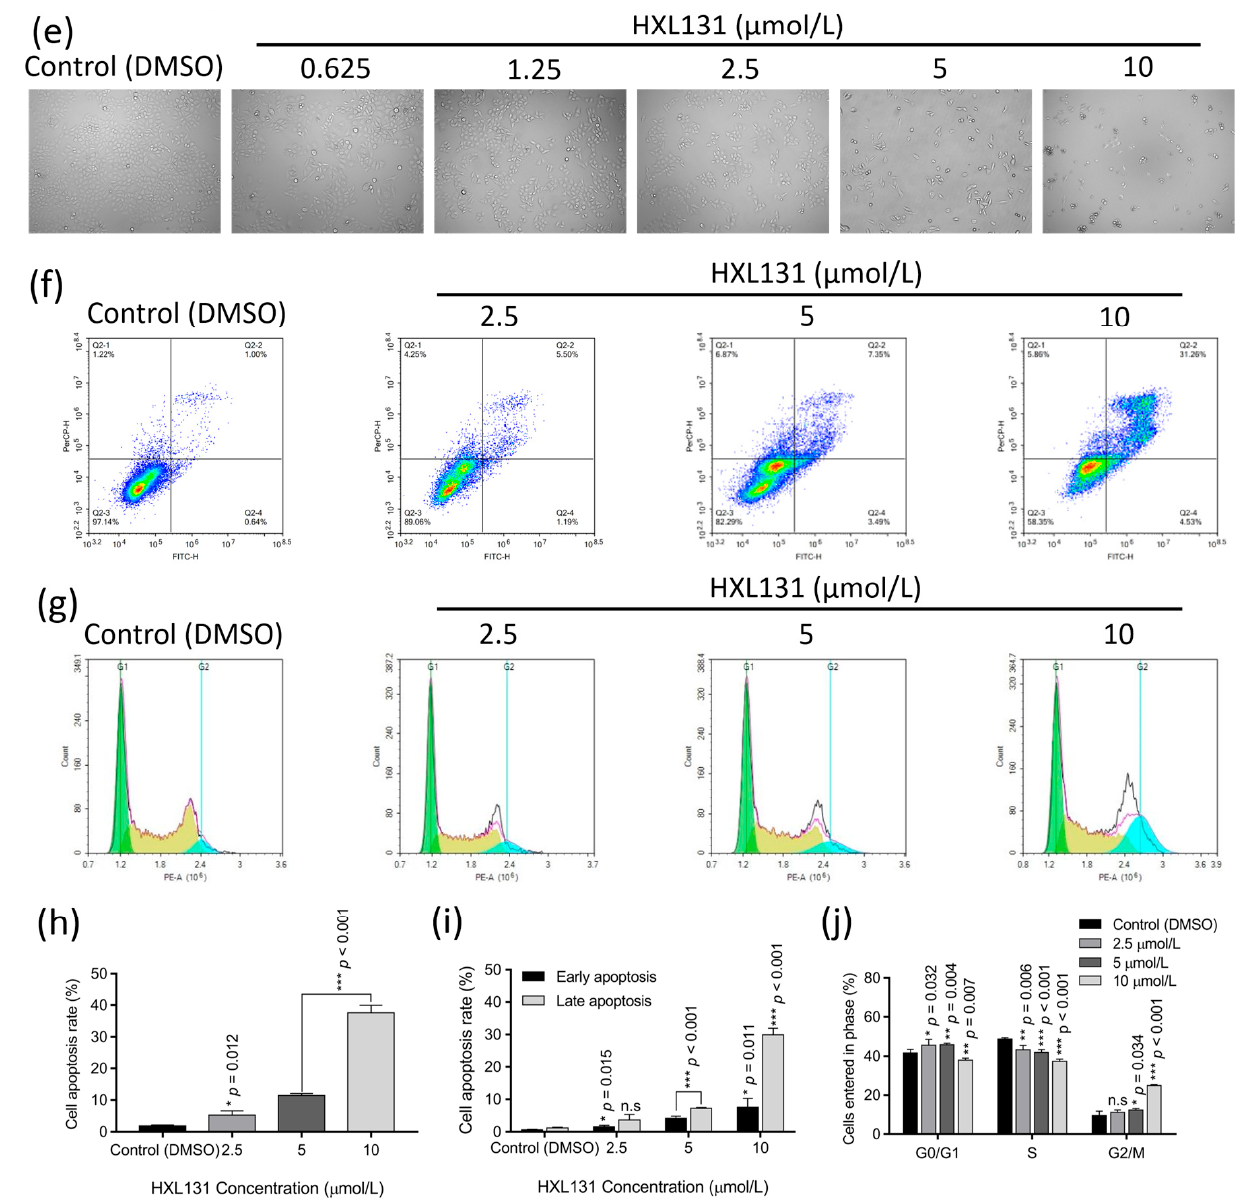
Figure 1. Evaluation of HXL131 toxicity in normal hepatocyte LO2 and the effect of this compound on PC3 cell growth at different concentrations. ( a ) The structural formula of the compound HXL131; ( b ) By comparing the proliferation inhibition of PC3 cells and LO2 cells, HXL131 was more inhibitory in PC3 cells, while indicating less toxicity in LO2 cells; ( c ) A [3-(4,5-dimethylthiazol-2-yl)-2,5-diphenyltetrazolium bromide] (MTT) assay was used to detect the inhibitory effect of different concentrations of HXL131 on the proliferation of PC3 cells; ( d ) The semi-inhibitory concentration (IC 50 ) values of HXL131 at different times (24, 48, and 72 h) were calculated by IBM SPSS Statistics 21.0 software; ( e ) Morphological changes of the PC3 cells that were treated with different concentrations of HXL131 for 24 h were observed using an inverted microscope (the magnification = ×100); ( f ) Apoptosis of PC3 cells at different concentrations of HXL131 was determined by flow cytometry; ( g ) Cell cycle changes of PC3 in the control (DMSO) group and HXL131 groups at different concentrations were detected by flow cytometry; ( h ) Total apoptosis rate of PC3 cells that were treated with different concentrations of HXL131; ( i ) Comparison of the effects of different concentrations of HXL131 on the early and late apoptosis rates of PC3 cells; ( j ) After the HXL131 treatment, the percentage of PC3 cells in three different phases of cell cycle was changed. Values are mean ± SD ( n = 3). * p < 0.05, ** p < 0.01, *** p < 0.001 vs. Control (DMSO) group; a p < 0.05, aaa p < 0.001 vs. PC3 cells group; n.s, non-significant. Multiple t -tests and one-way ANOVA were used for statistical